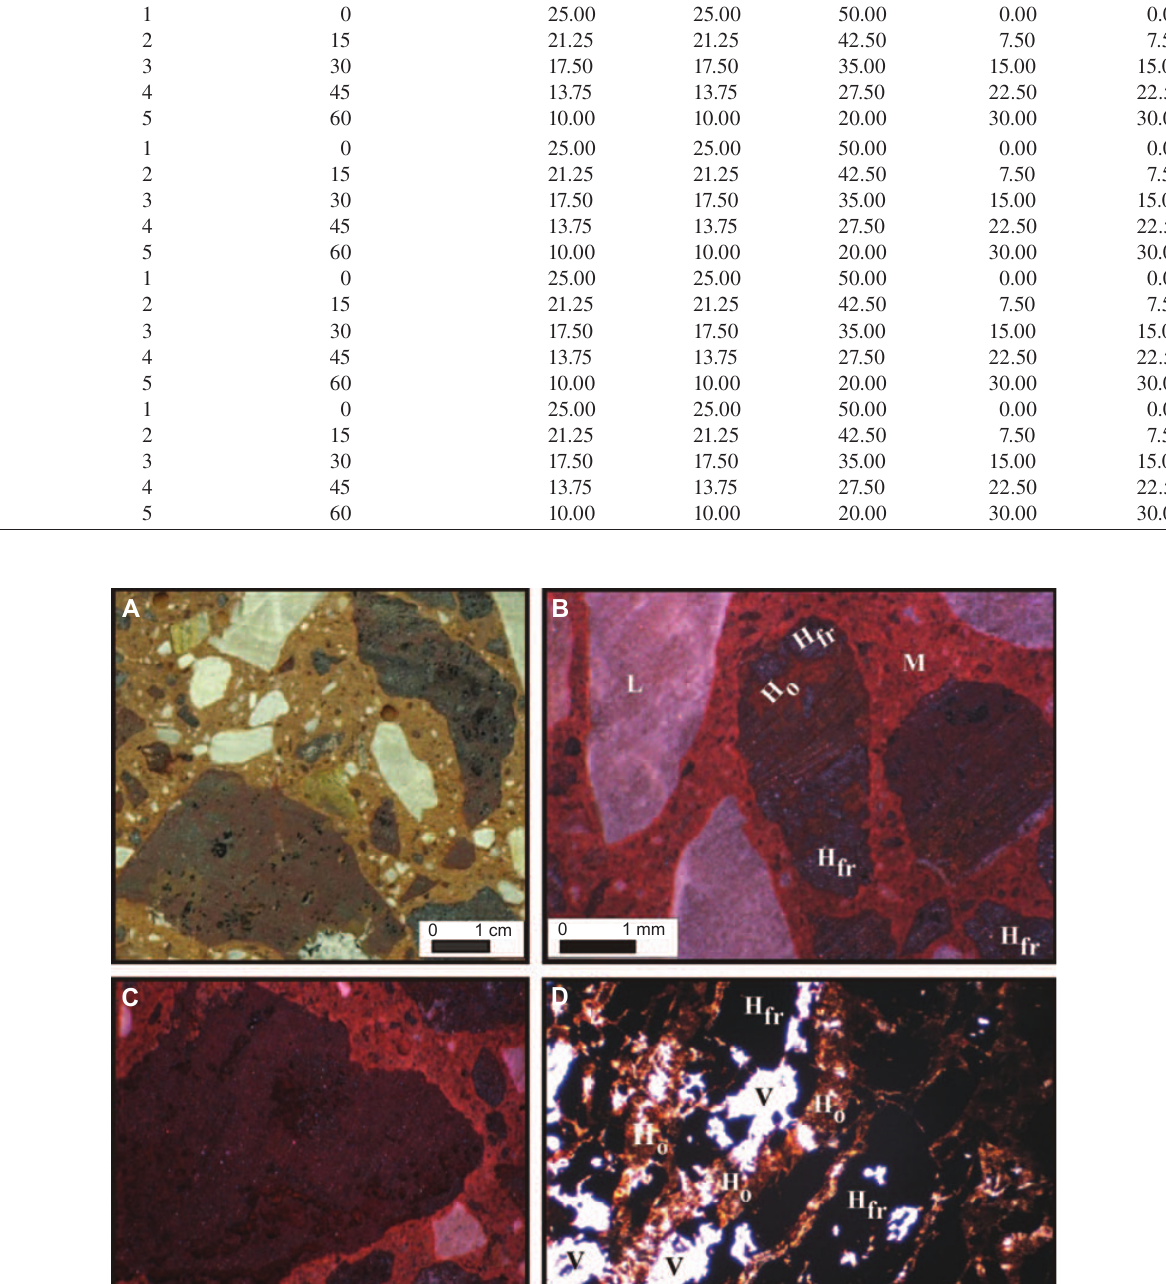
Table 7 Volumes of aggregates in the mixtures in % . Groups